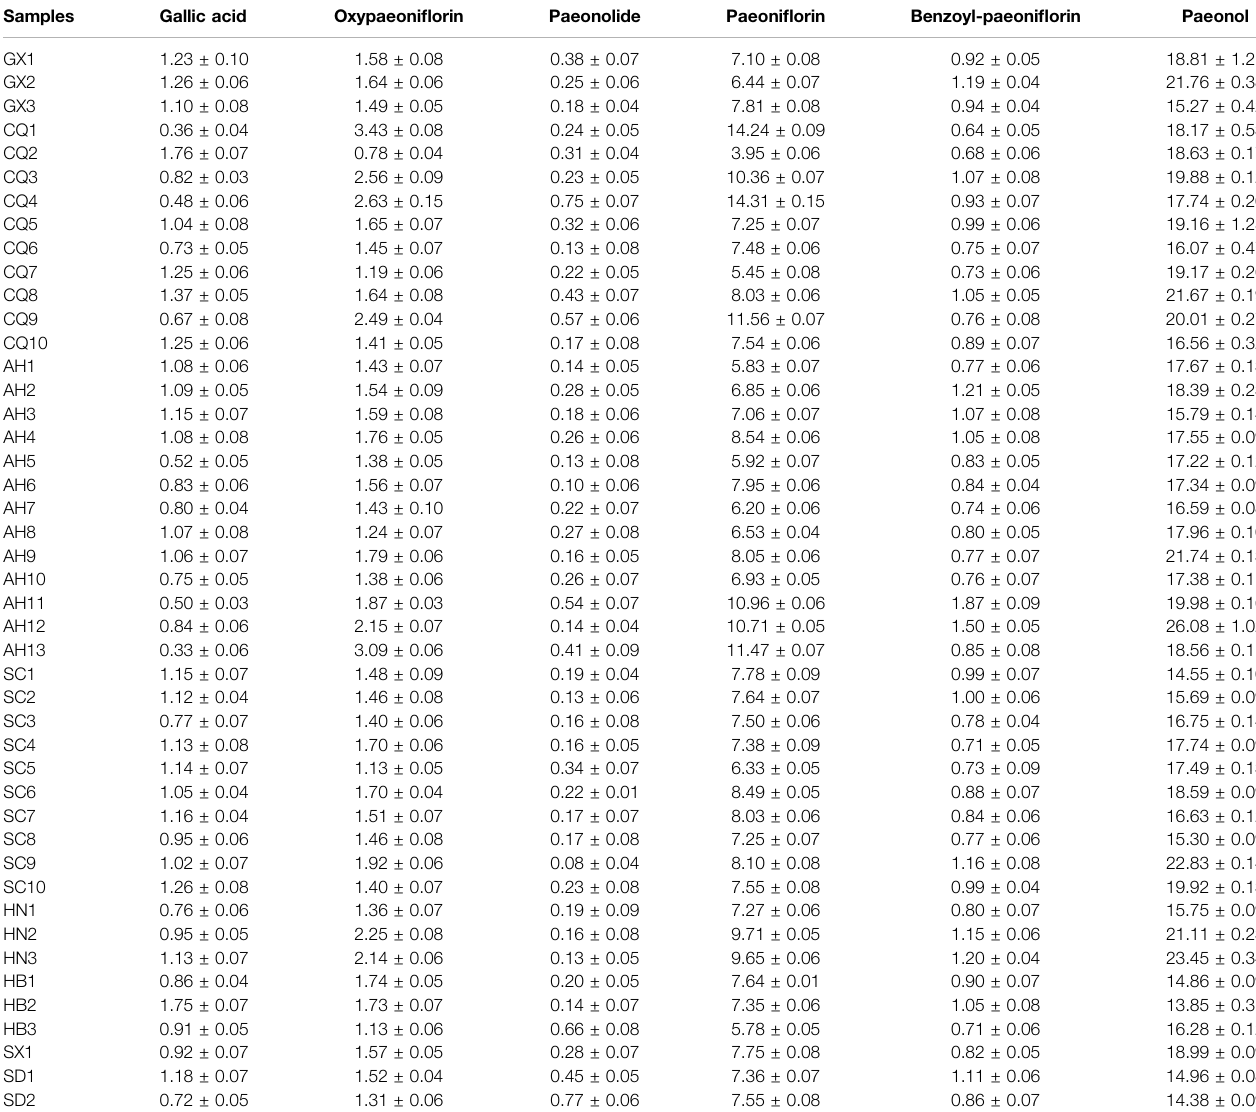
TABLE 1 | Contents of the six constituents in 45 batches of MC (mg . g − 1 , x ± SD, n (cid:2) 6 ).